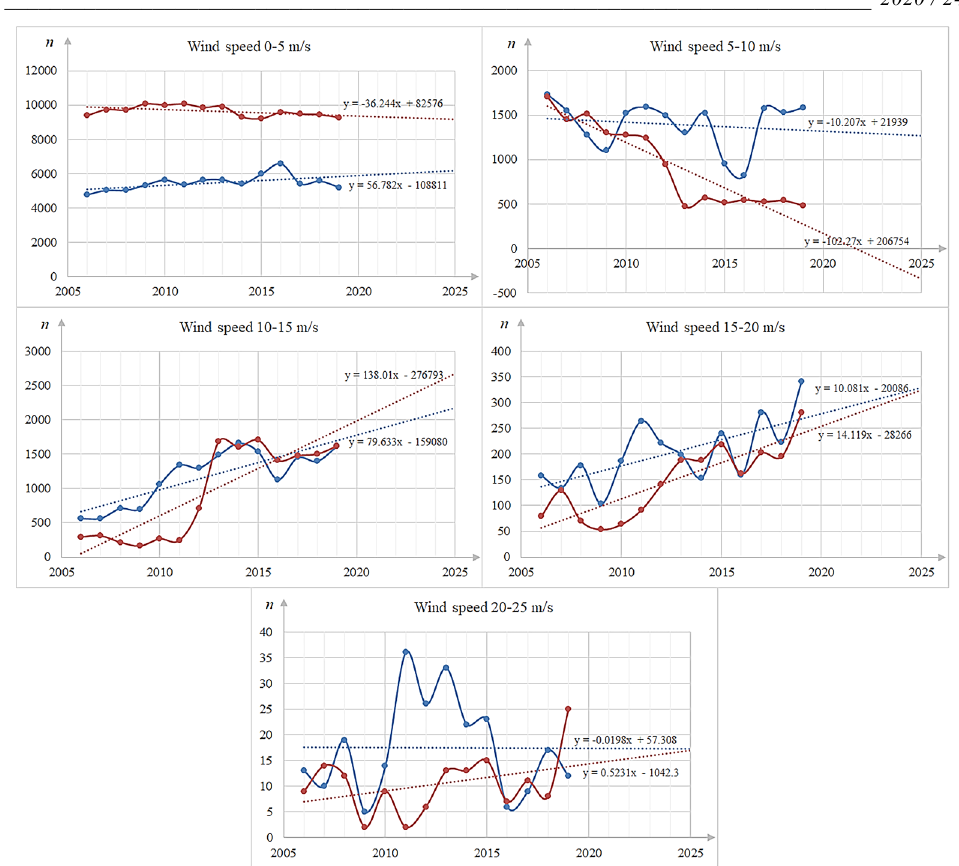
Fig. 5 . The number of recorded wind cases at a certain speed in the Republic of Bashkortostan from 2006 to 2025, where the blue curves are the north part, the red curves are the south